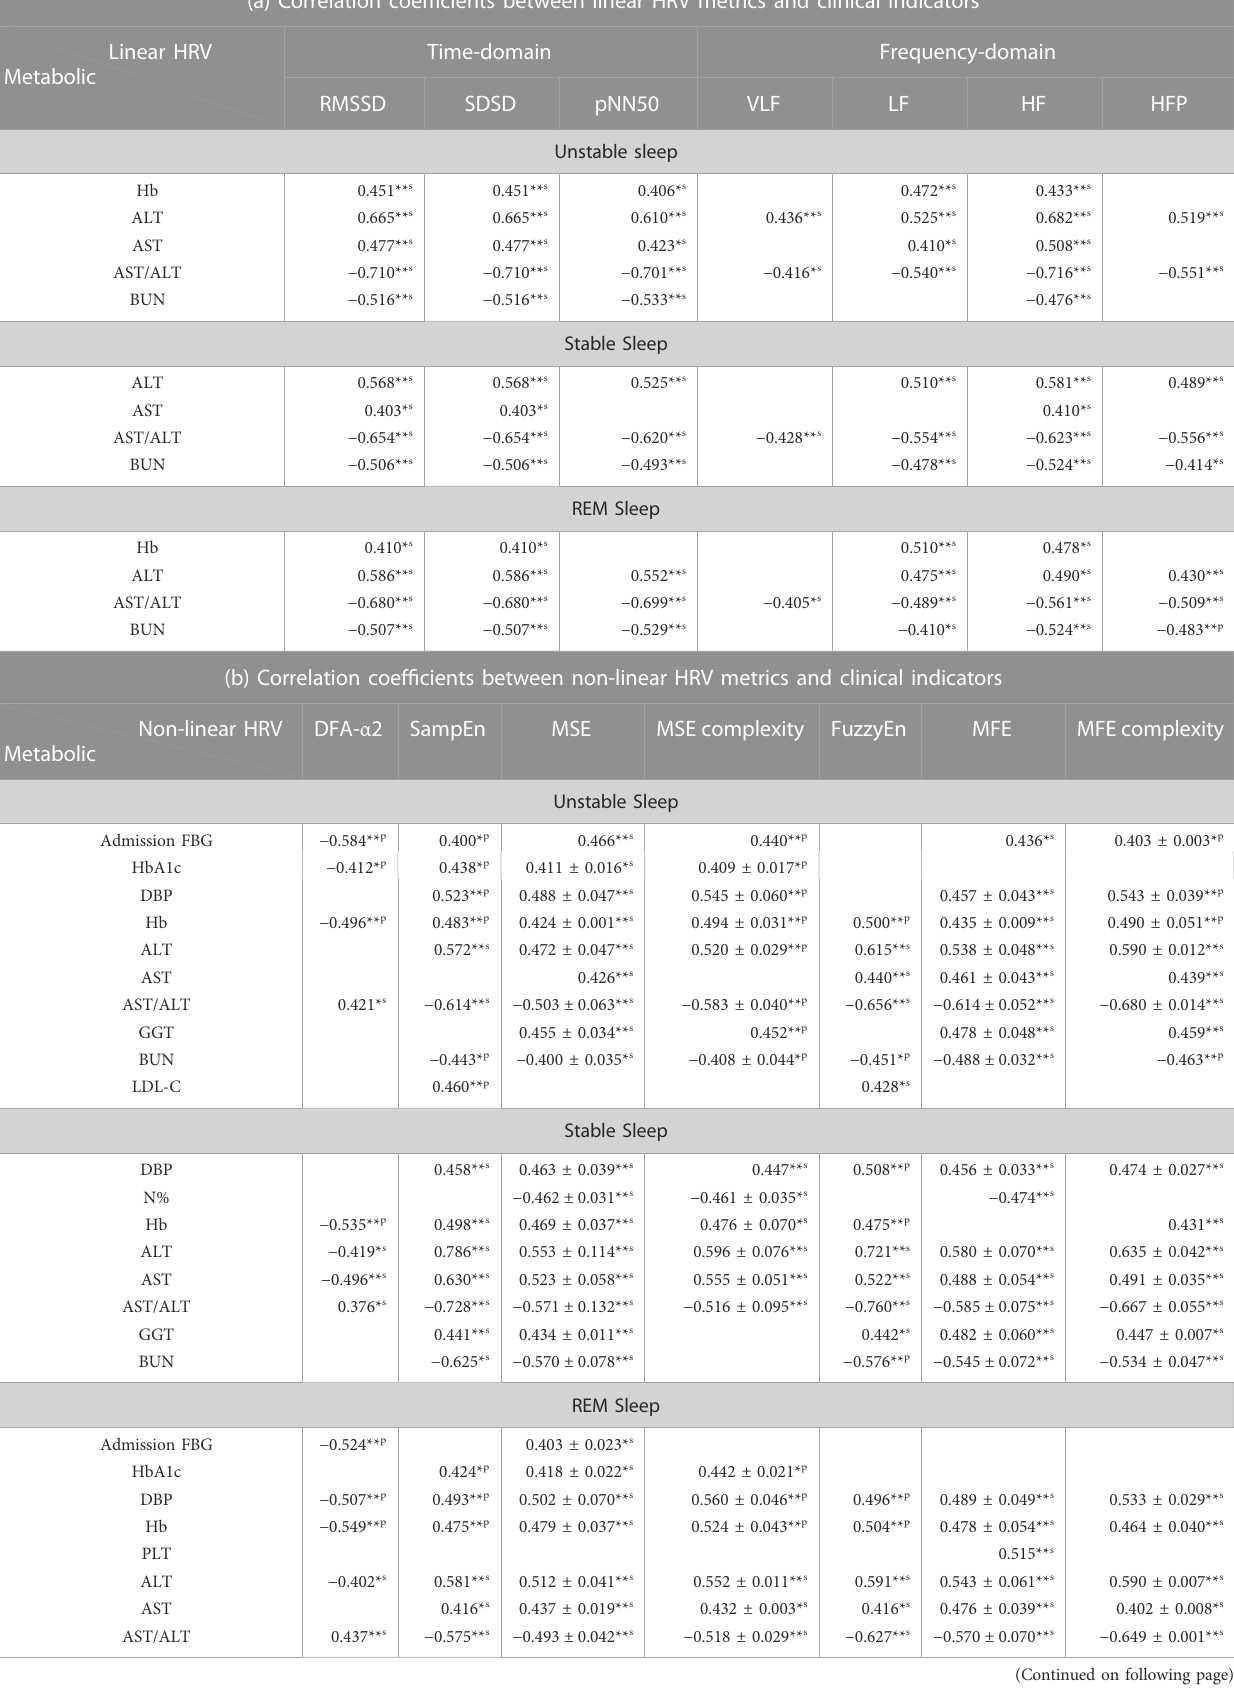
(b) Correlation coef fi cients between non-linear HRV metrics and clinical